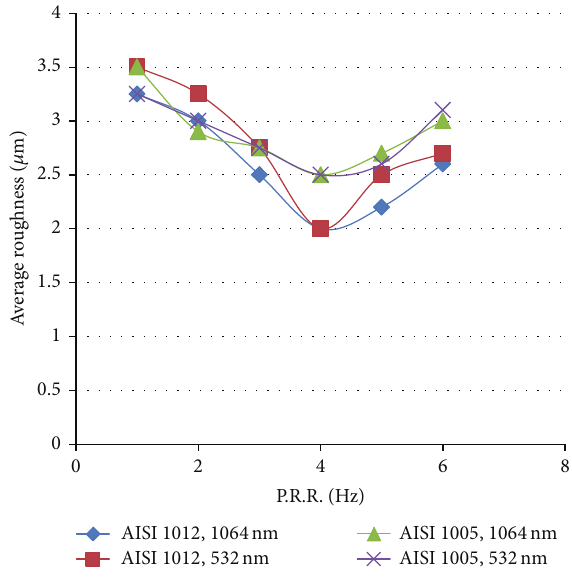
Figure 10: Variation of (𝑅 𝑎 ) as a function of PRR at 𝑃 𝑝